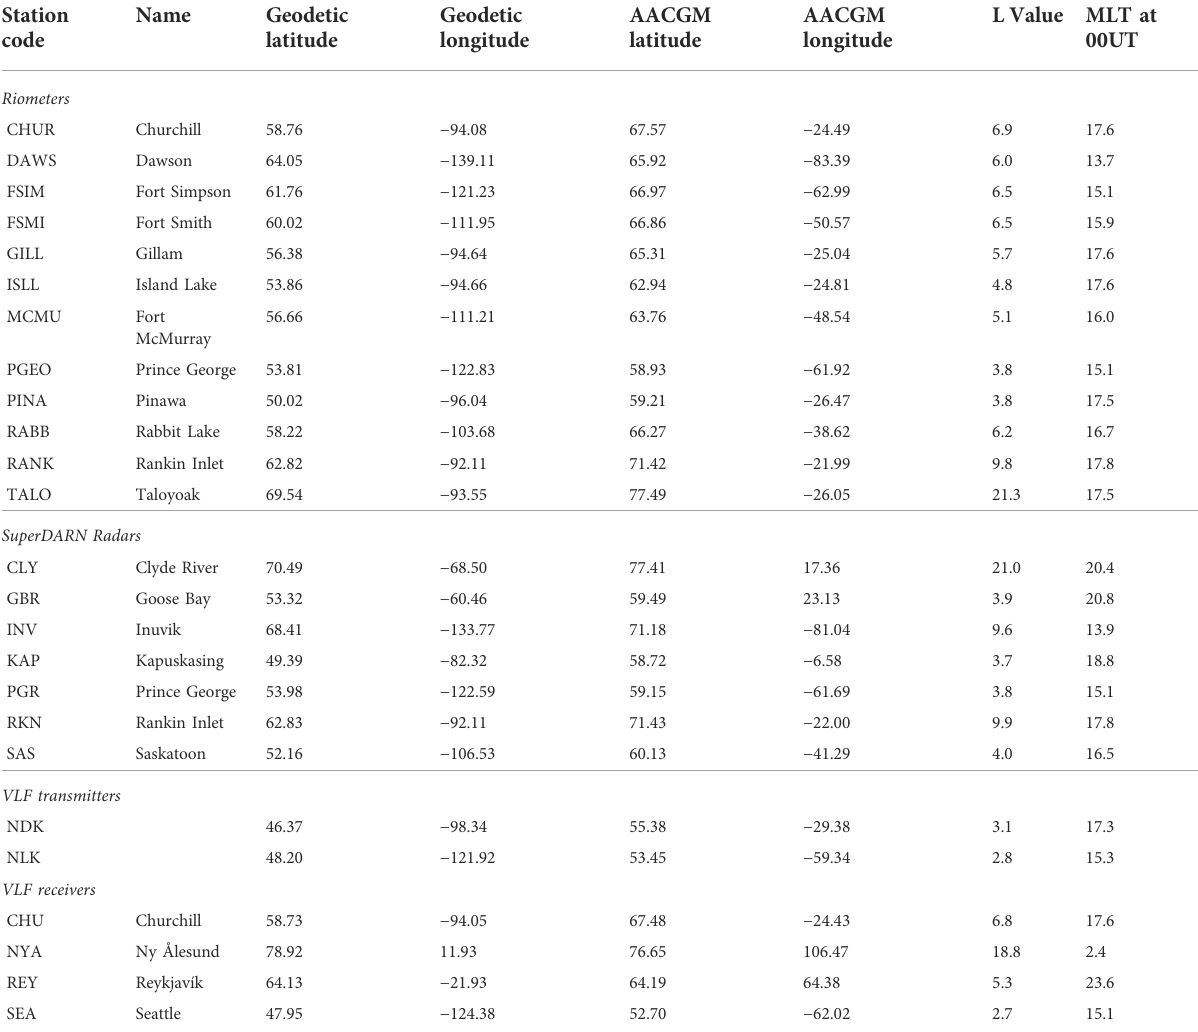
TABLE 1 Station codes and locations of the riometers, SuperDARN radars, and VLF transmitters and receivers used in this study. AACGM = Altitude- Adjusted Corrected Geomagnetic. MLT = magnetic local time. Station